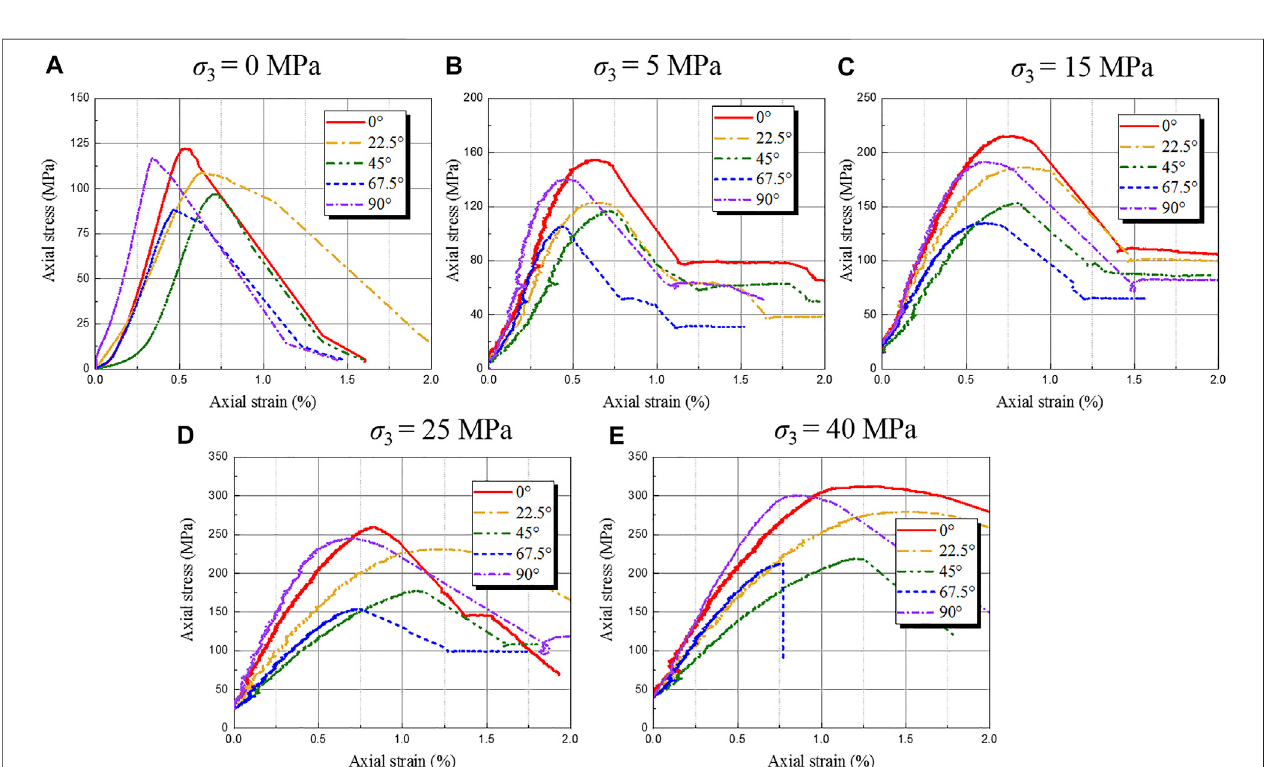
FIGURE 5 | Experimental data of compressive strength of bedded rock. (A) σ 3 = 0 MPa; (B) σ 3 = 5 MPa; (C) σ 3 = 15 MPa; (D) σ 3 = 25 MPa; (E) σ 3 = 40 MPa.